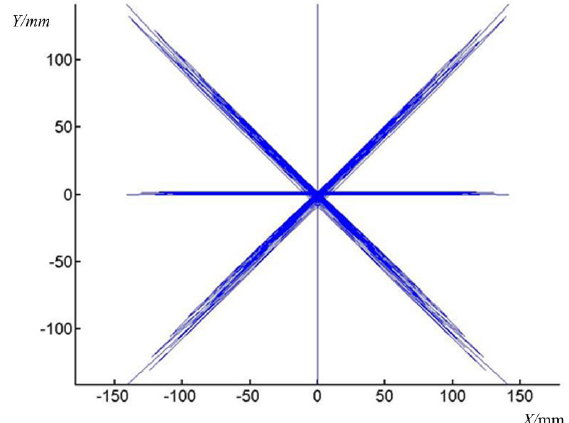
Figure 22. Responses of the displacements of the platform in case